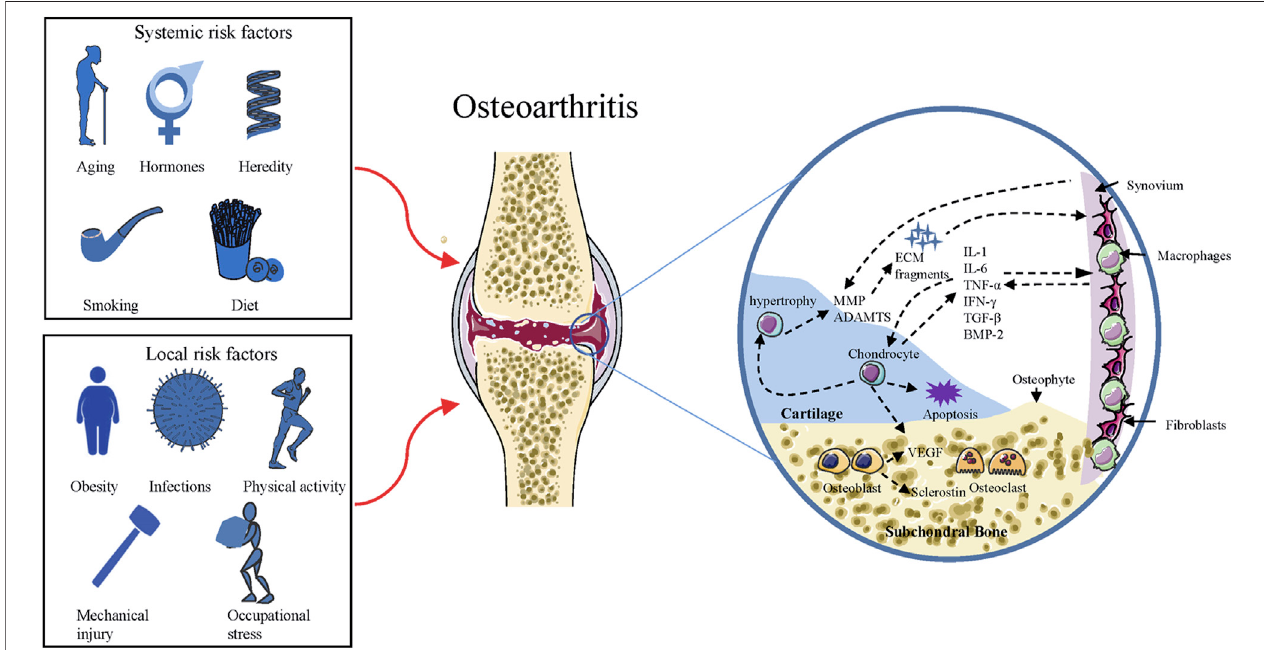
FIGURE1| RiskfactorsandpathogenicprocessofOA.SquaresontheleftsideincludetheriskfactorsresponsibleforthedevelopmentofOA,andthecircleonthe rightsiderepresentsthepathogenicprocessofOA.ADAMTS (cid:1) adisintegrinandmetalloproteinasewiththrombospondinmotifs;MMP (cid:1) matrixmetalloproteinase;ECM (cid:1) extracellular matrix; IL (cid:1) interleukin; TNF (cid:1) tumor necrosis factor; IFN (cid:1) Interferon; BMP (cid:1) bone morphogenic protein; TGF (cid:1) transforming growth factor; VEGF (cid:1) Vascular endothelial growth factor.